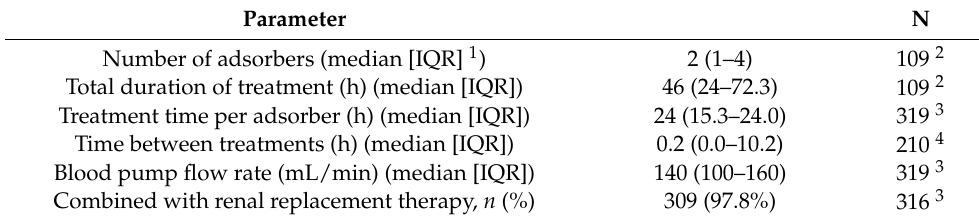
Table 2. Treatment characteristics.